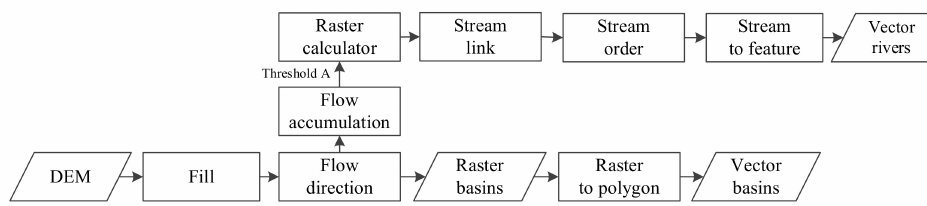
Figure 2. Flowchart of extracting basins and rivers.